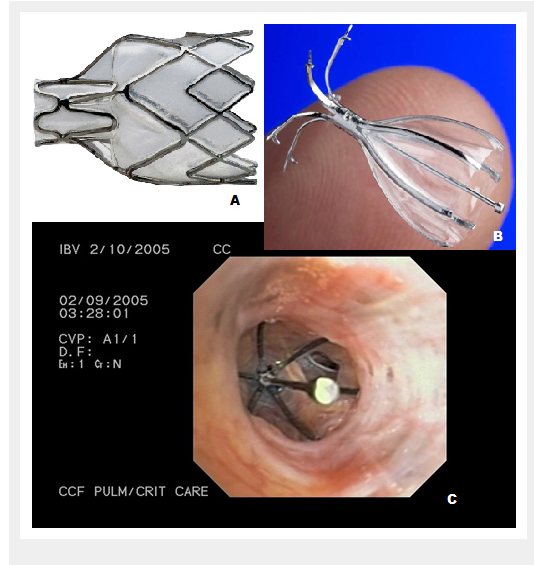
A– Pulmonx intrabronchial valve; B- Spiration valve; C- Bronchoscopic view of the Spiration valve in situ.